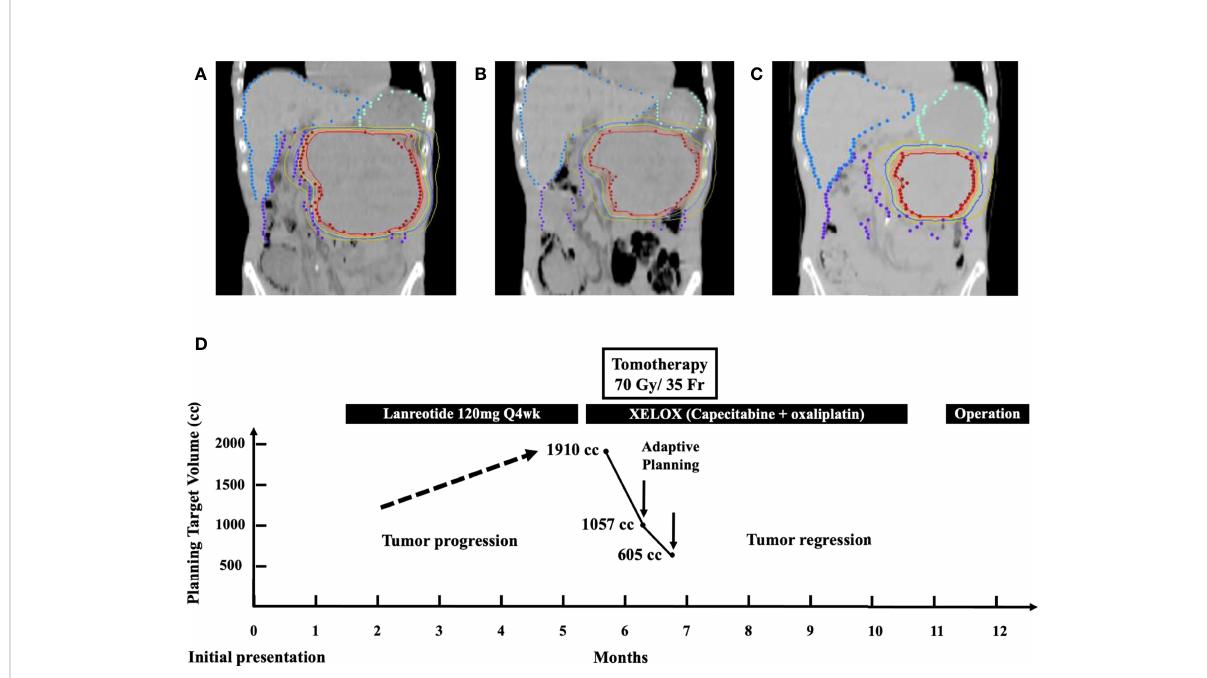
FIGURE 3 (A) Isodose curves depicting a target volume of 1,910 cc in the initial treatment plan of Tomotherapy. (B) Target volume reduced from 1,910 to 1,057 cc after 14 fractions. (C) Target volume reduced from 1,057 to 605 cc after 10 fractions. (D) Multidisciplinary treatment course of the patient from the day of initial presentation until de fi nitive surgery: adaptive Tomotherapy plans were administrated twice at the timing of substantial target volume reduction from 1910 to 1,057 cc and from 1,057 to 605 cc,